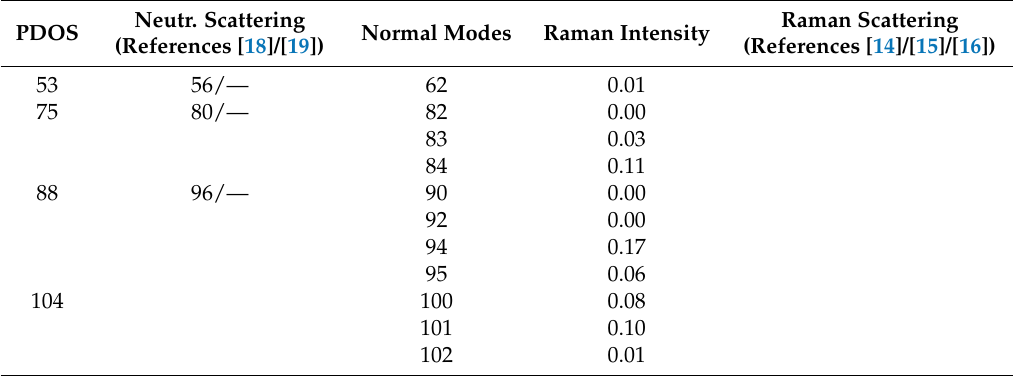
Figure 1. The simulated spectrum of ice XIV. The four images correspond to four vibration bands: translation, libration, bending, and stretching. Each image from top to bottom is Raman, IR, and the PDOS spectrum, respectively. Weak peaks were amplified reasonably. Table 1. Comparison of calculated results with Raman and INS data. The main peaks of PDOS in the first column are compared against INS spectrum. The frequencies of 105 normal vibration modes with Raman intensities are compared against the experimental Raman